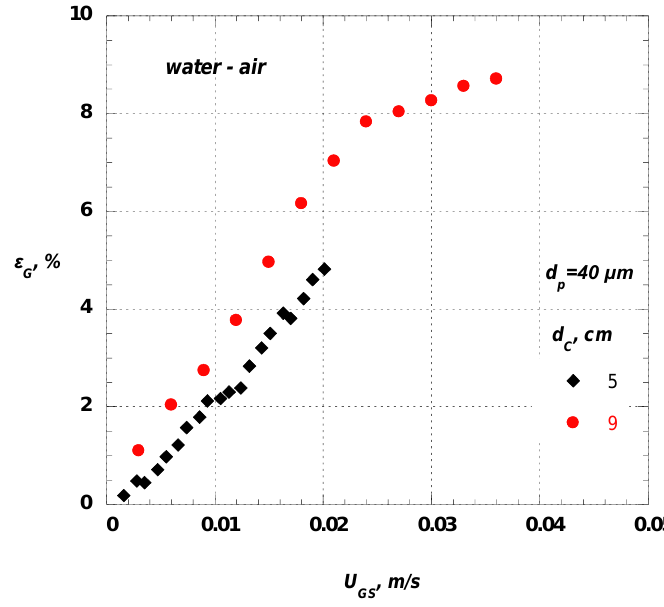
Figure 6. Effect of column diameter on gas holdup for the water-air system ( d p = 40 μm).